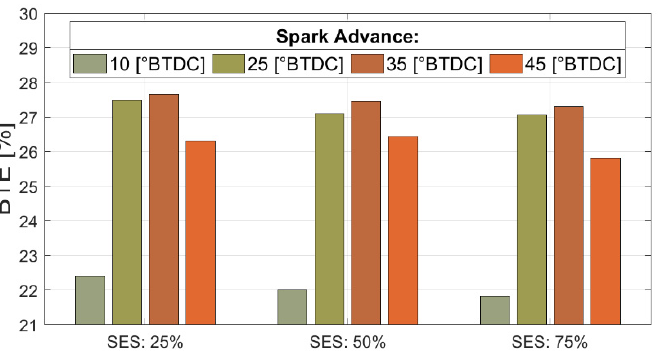
Figure 5. Brake thermal efficiency power for different spark advance and syngas energy share.